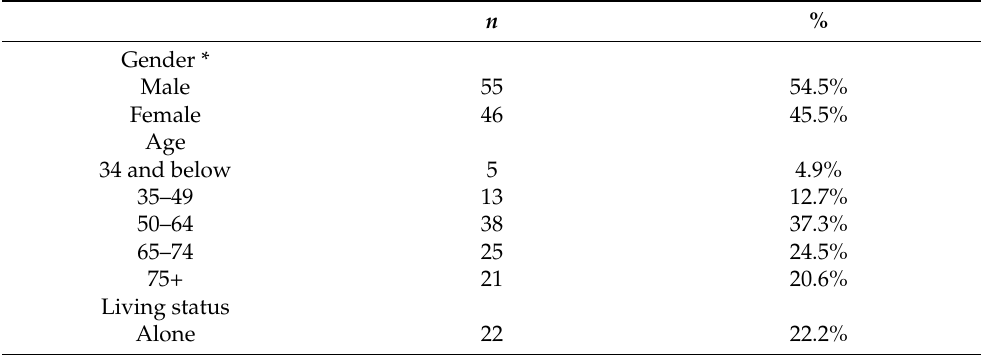
Table 1. Demographic characteristics of